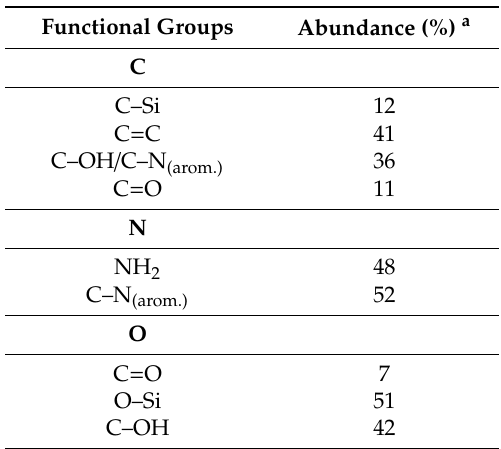
Table 2. Functional groups present in the PolyCat-Si obtained by the deconvolution of XPS spectra.